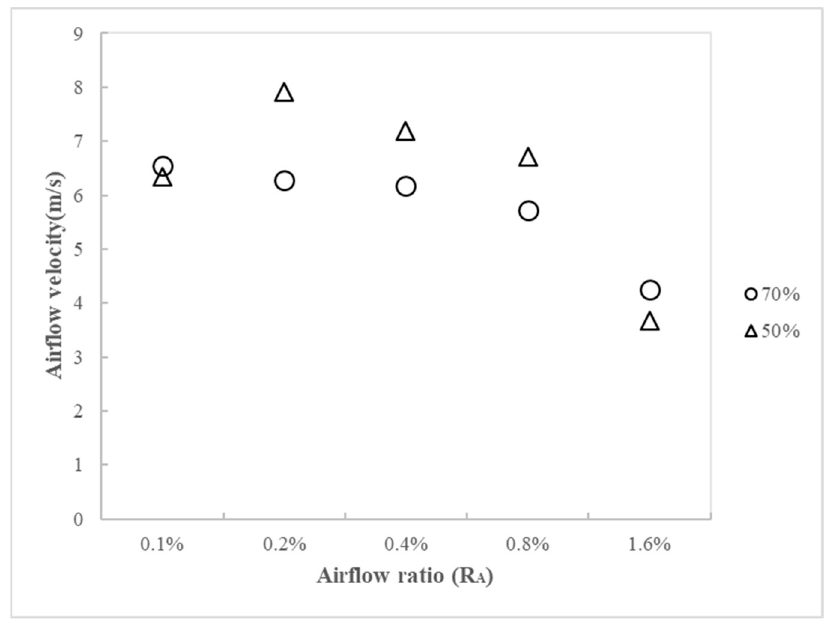
Figure 16. Air flow velocity corresponding to height ratio R Z of OWC chamber.